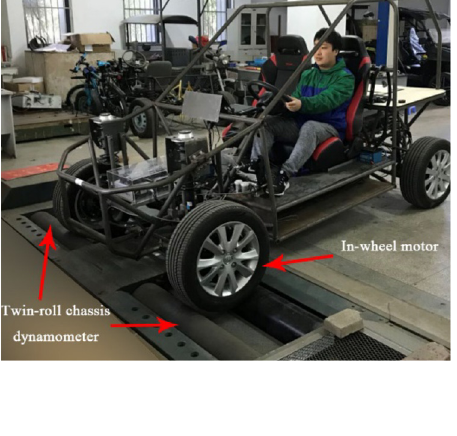
Figure 5 IWMs EV chassis dynamometer test